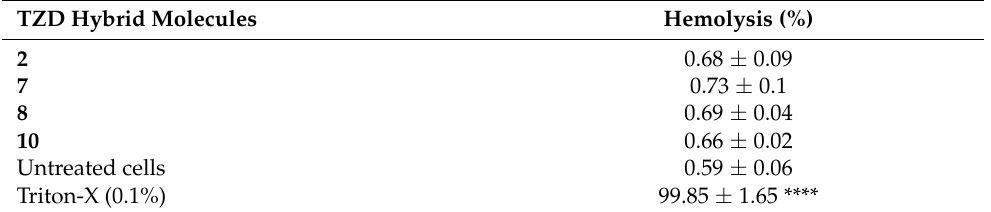
Table 2. Effect of TZD hybrid molecules 2 , 7 , 8 and 10 on red blood cell hemolysis. TZD Hybrid